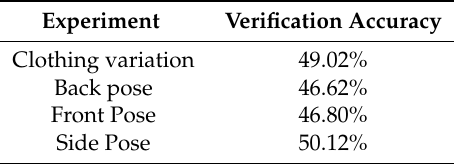
Table 9. SOMAset verification accuracy under clothing and pose variations as achieved by the Siamese